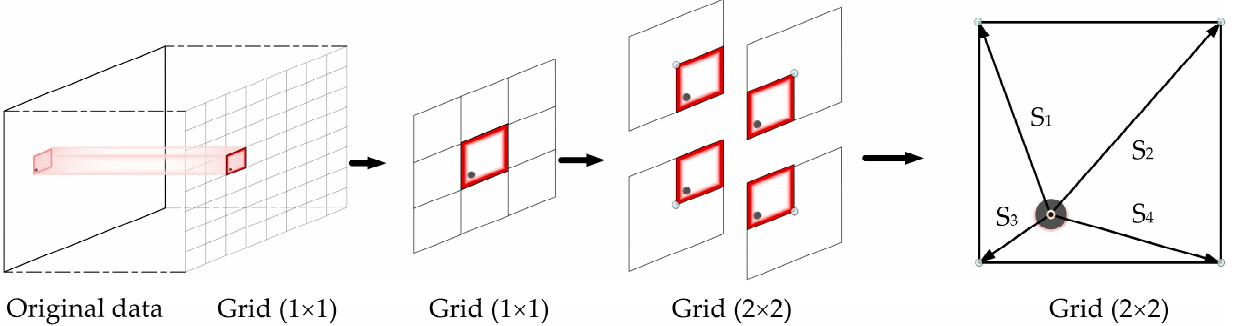
Figure 6. Schematic of the partition-fitting strategy.